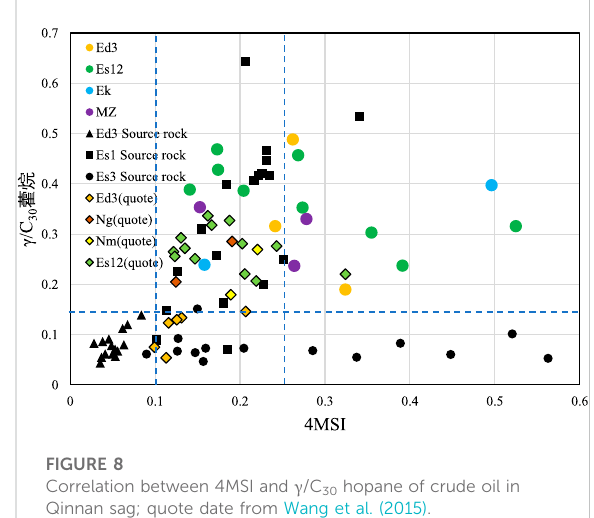
FIGURE 8 Correlation between 4MSI and γ /C 30 hopane of crude oil in Qinnan sag; quote date from Wang et al. (2015).